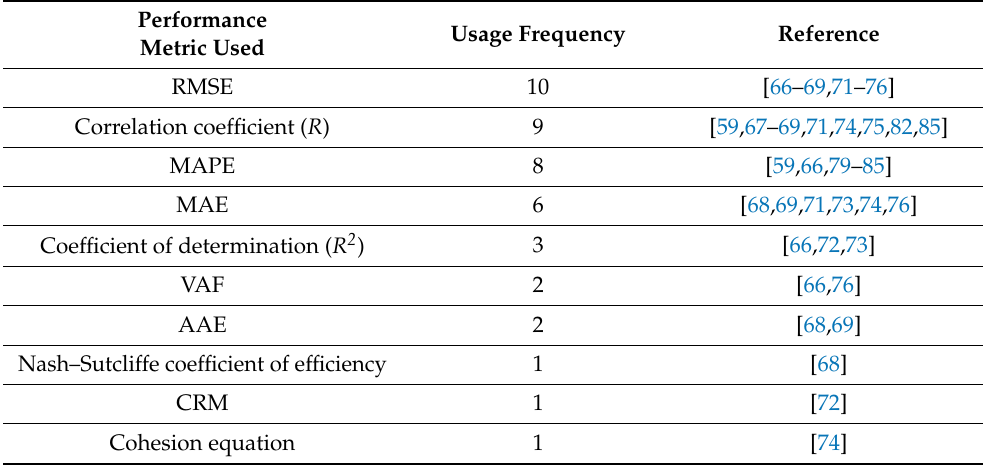
Table 8. Most commonly used performance metrics for deciding the soil shear strength and pre- project cost and